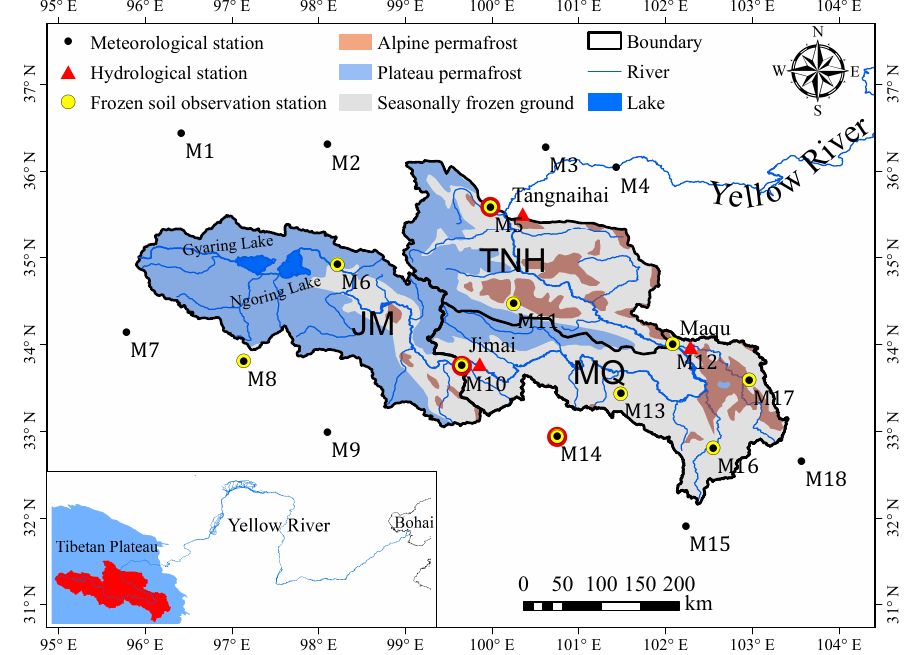
Figure 1. Relative location of the three sub-basins (Jimai (JM), Jimai-Maqu (MQ), and Maqu-Tangnaihai (TNH)), distribution of frozen ground, and meteorological and hydrological stations (the red circles indicate stations that have the longest frozen-ground record in their respective